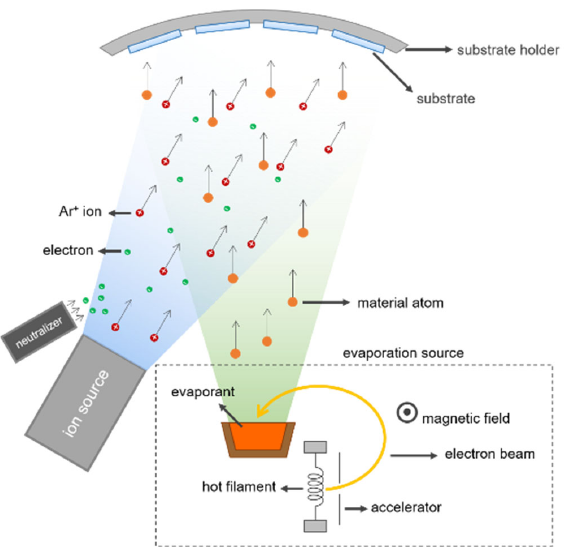
Figure 2. Schematic drawing of an ion ‐ assisted electron ‐ beam evaporation coating system.